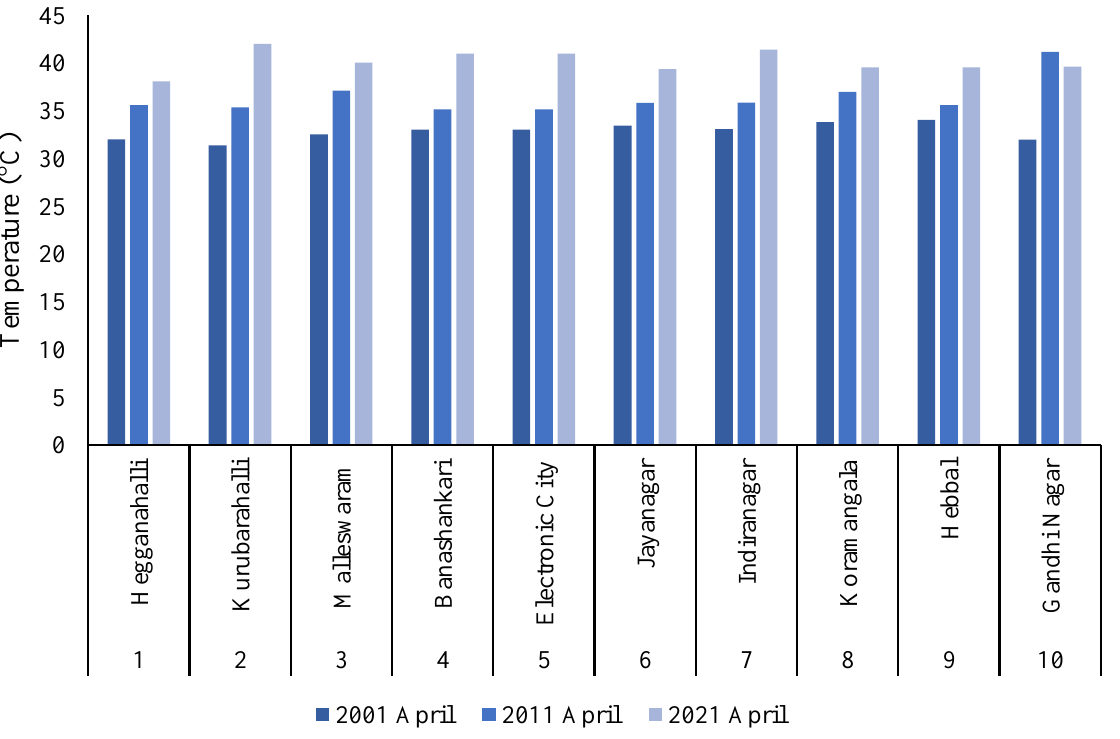
Figure 12. Land surface temperature assessment bar diagram of ten field reference locations of urbanized areas.